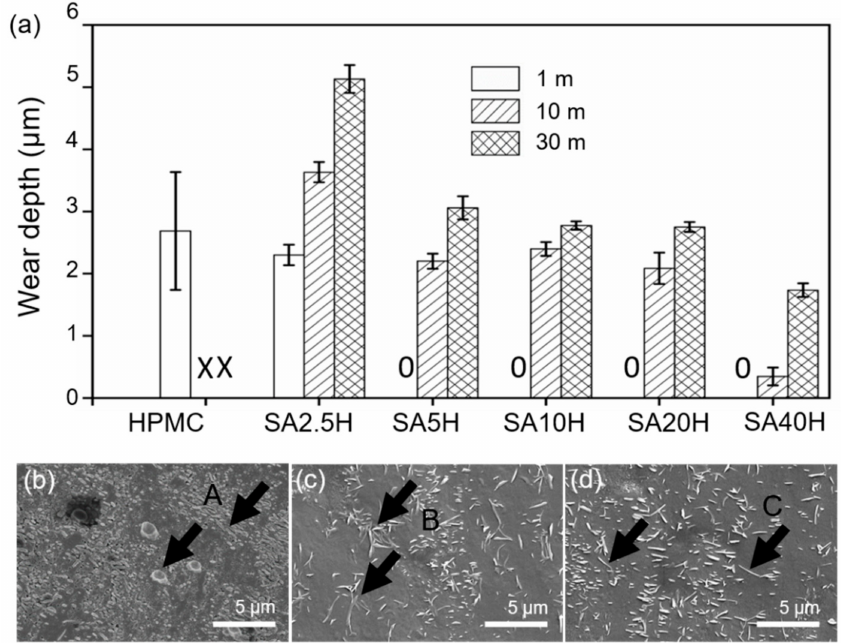
Figure 8. ( a ) Wear performance of composite coating. Wear depth and surface morphology at ( b ) 1 m, ( c ) 10 m, and ( d ) 30 m (SA20H, 2 N; X represents that the film is worn through; 0 represents that the wear depth is